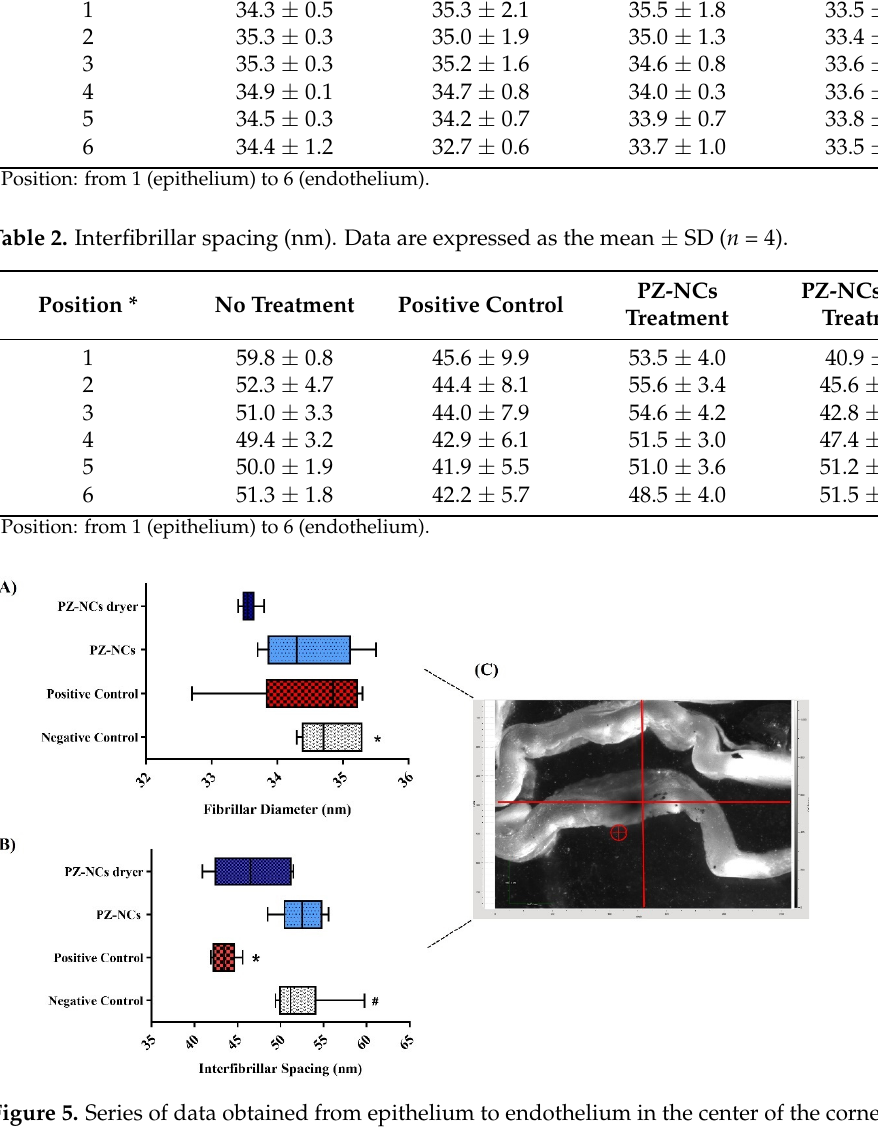
PZ-NCs PZ-NCs Dryer Treatment Treatment